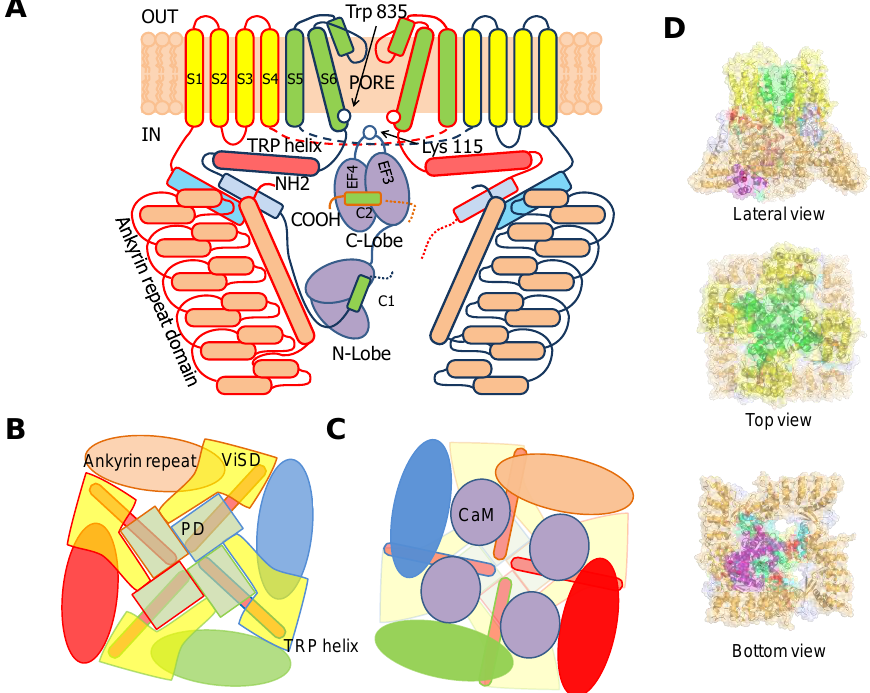
Figure 9. Representation of TRPV5 / 6 channels. ( A ). Transmembrane regions are in yellow for the ViSD, green for the PD and calmodulin in purple. Only two of the four subunits are represented, with a red or blue border. The ankyrin repeats are in orange, and the TRP helix in red. ( B) . Realistic representation of the channel view from the top using the same color scheme as in A. The border of each subunit has a di ff erent border color and the ankyrin repeats have been filled with its corresponding color. ( C ). View from the bottom. Four hemi-CaM molecules within the dome are represented. ( D ). Structures visualized using then PDB coordinates (6E2G), rendered with Pymol 1.30 using the same color scheme as in panel A.